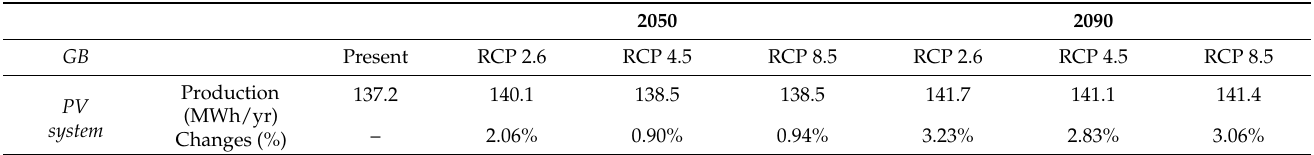
Table 2. Predicted PV production for the